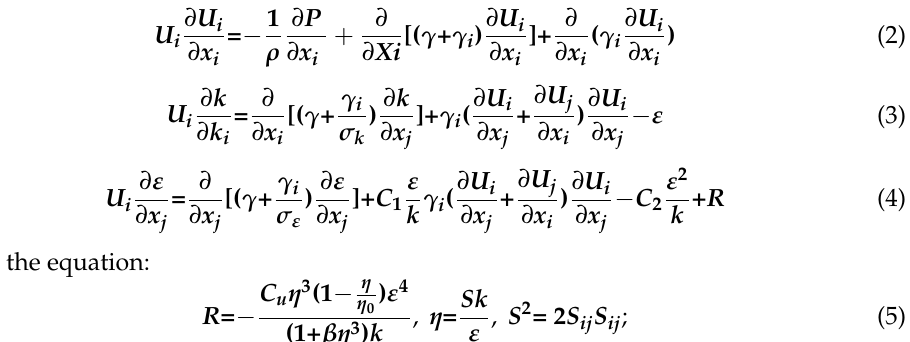
Figure 4. Shandong annual wind frequency chart (latitude 36°52 ′ , longitude 116°14 ′ ). In Figure 5, the first line from top to bottom is the annual maximum temperature distribution curve. The second line is the minimum yearly temperature distribution curve, and the column shows the annual rainfall.